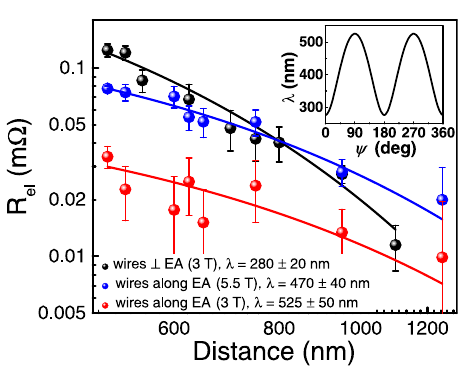
Fig. 3 | Distance dependence of spin transport signal at 200K. Nonlocal spin transportsignal R el as a function of centre-to- centre distance between of the wires fordeviceswherewiresarealongtheeasy-axisat μ 0 H =5.5Tand3Tandfordevices where wires are perpendicular to the easy-axis at μ 0 H = 3T. The error bars are standard errors of the mean. The solid lines are the fi t to an exponential decay function which yields value of λ of 470±40nm and 525±50nm at 5.5T and 3T, respectively,forthedevicesshowninFig.2aand280±20nmat3Tforthedevices showninFig.2b.Inset,theoreticalcalculationof λ asafunctionofangle ψ measured from the easy-axis, considering the experimental value of λ along and perpendi- cular to the easy-axis.